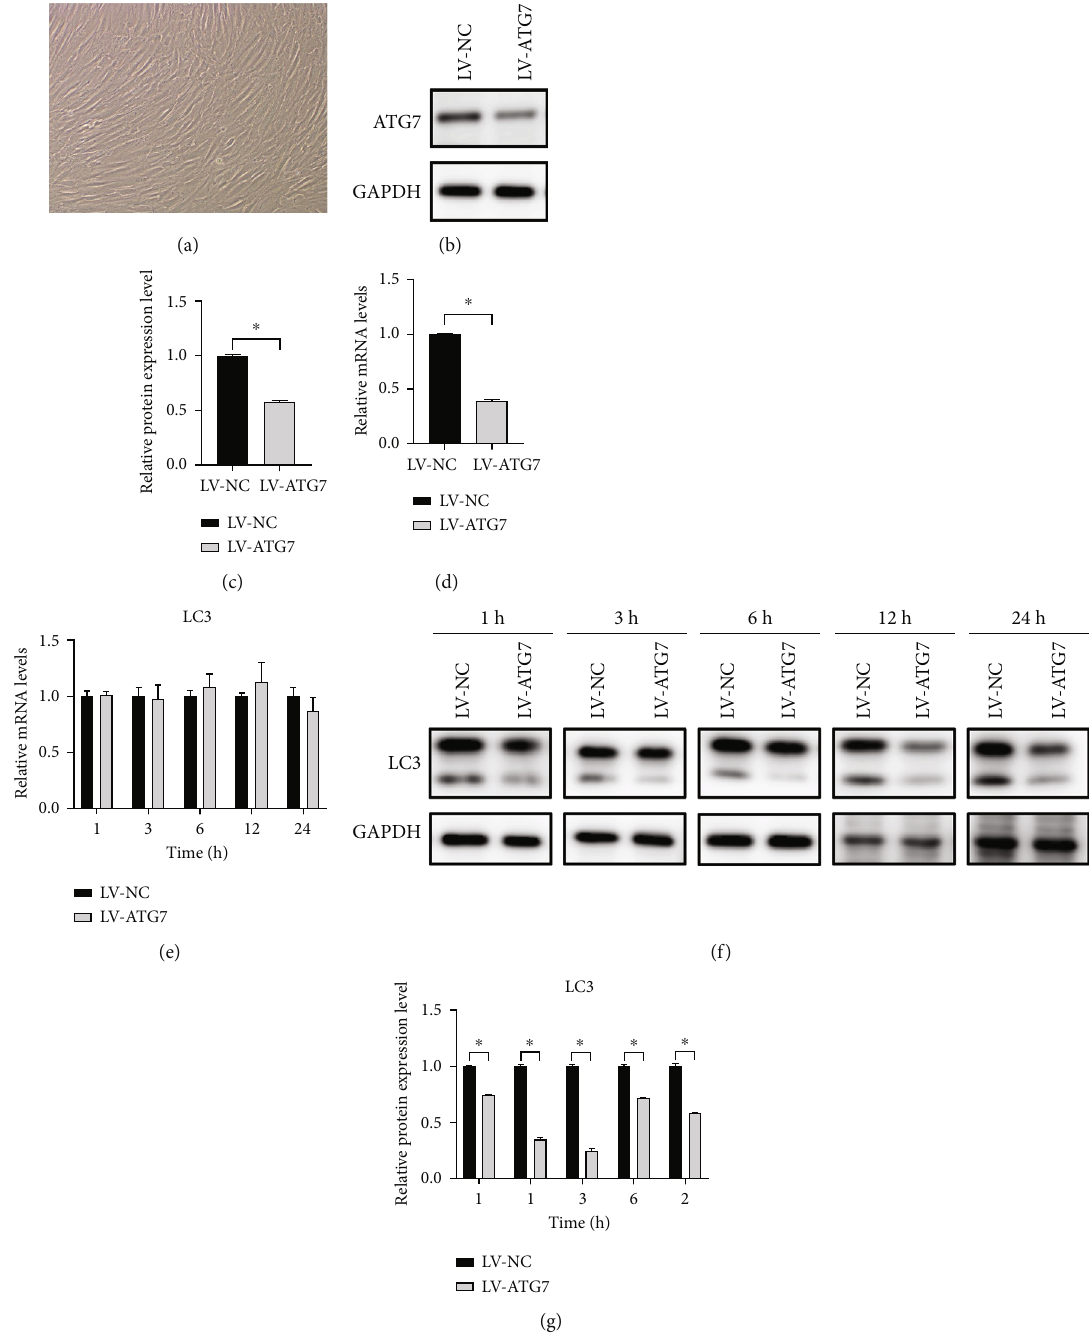
Figure 5: The inhibition of autophagy by knocking down the autophagy-related gene ATG7 of hPDLSCs. (a – d) Lentiviral transfection e ffi ciency detection. (e) LC3-relative mRNA expression levels assessed by real-time PCR in both the LV-NC and LV-ATG7 groups. (f, g) LC3-relative protein expression levels assessed by western blotting in both the LV-NC and LV-ATG7 groups. ∗ P < 0 : 05 . hPDLSCs: human periodontal ligament stem